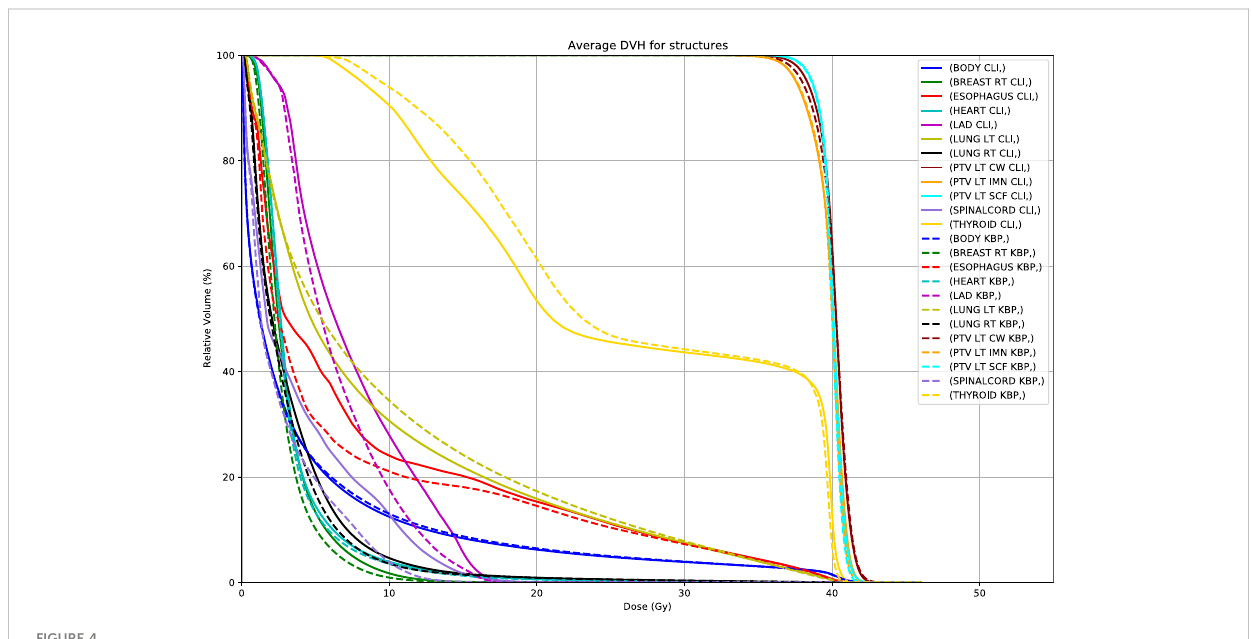
FIGURE 4 Average DVH comparison of CLI and KBP_40Gy in 15